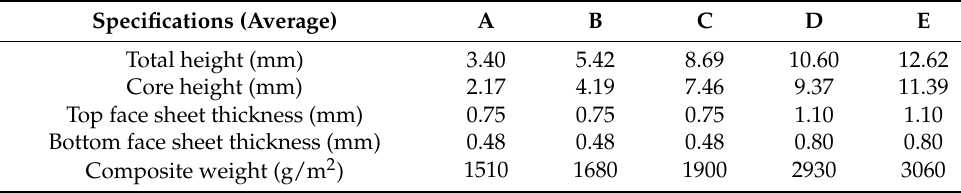
Table 2. Specifications of 3D integrated woven spacer sandwich composite